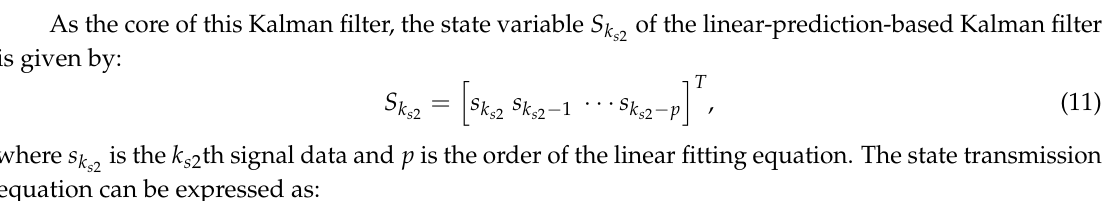
Figure 3. Illustration of the linear prediction model.